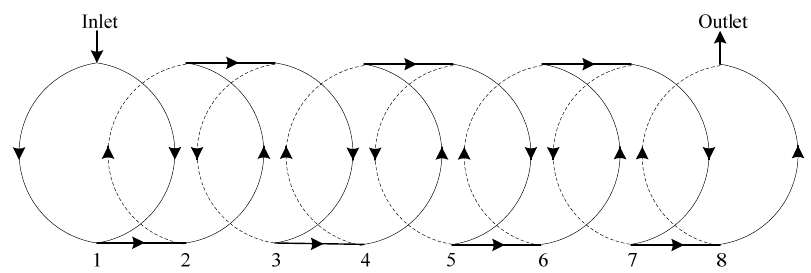
Figure 3. Schematic diagram of the water flow in the water channels.